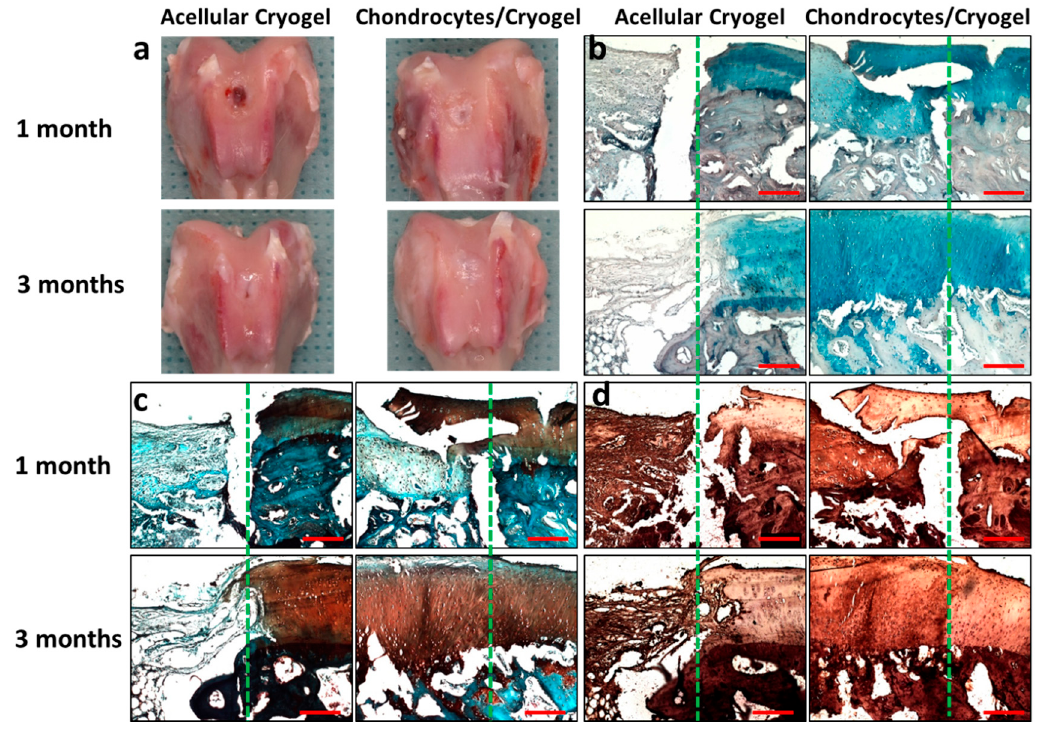
Figure 10. ( a ) Gross observation; ( b ) Alcian blue; ( c ) Safranin O and ( d ) type II collagen immunohistochemical staining of the explanted samples 1 and 3 months post-implantation. The articular cartilage defects of rabbits were repaired with GH-GlcN16 cryogel (acellular cryogel) or chondrocytes-seeded GH-GlcN16 cryogel (chondrocytes/cryogel). The defect creation boundary is shown as the dotted line in each panel with native cartilage to the right. Bar = 200 μ m.